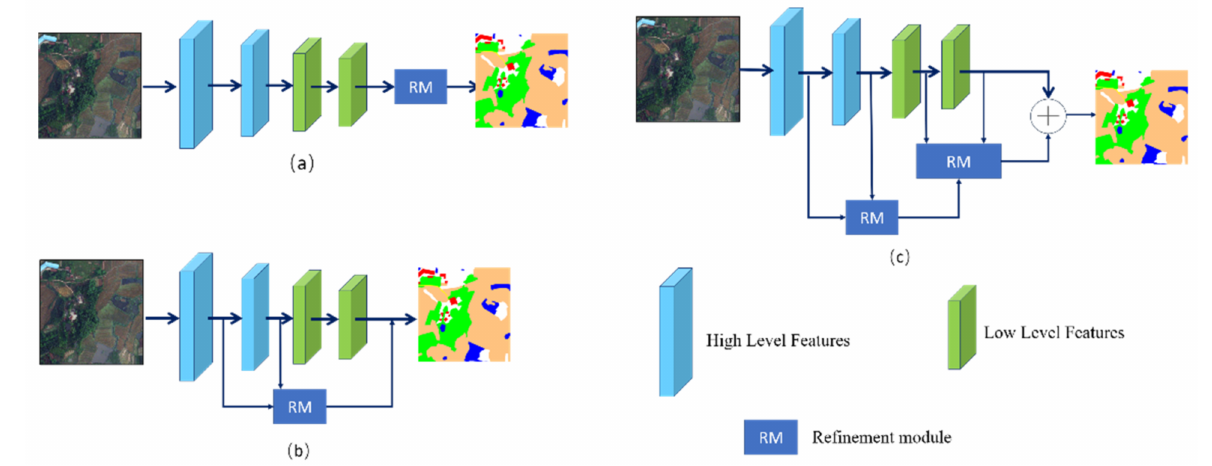
Figure 1. Three boundary refinement structures. ( a ) The refinement of high-level features. ( b ) The refinement of low-level features. ( c ) Module with hierarchical refinement (ours). “RM” indicates refinement